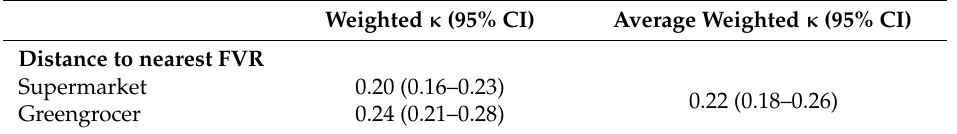
Table 2. Agreement between objective and perceived distances to the nearest type of FVR ( n =